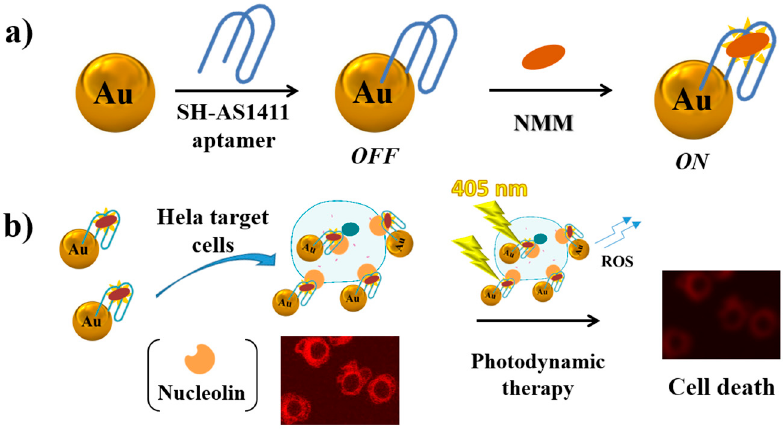
Figure 19. Schematic representation of ( a ) preparation of AS1411-functionalized gold nanoparticles bound with fluorescent N -methylmesoporphyrin IX (NMM) and ( b ) possible use of this system for both cancer cell imaging and photodynamic therapy, as described in reference [229].